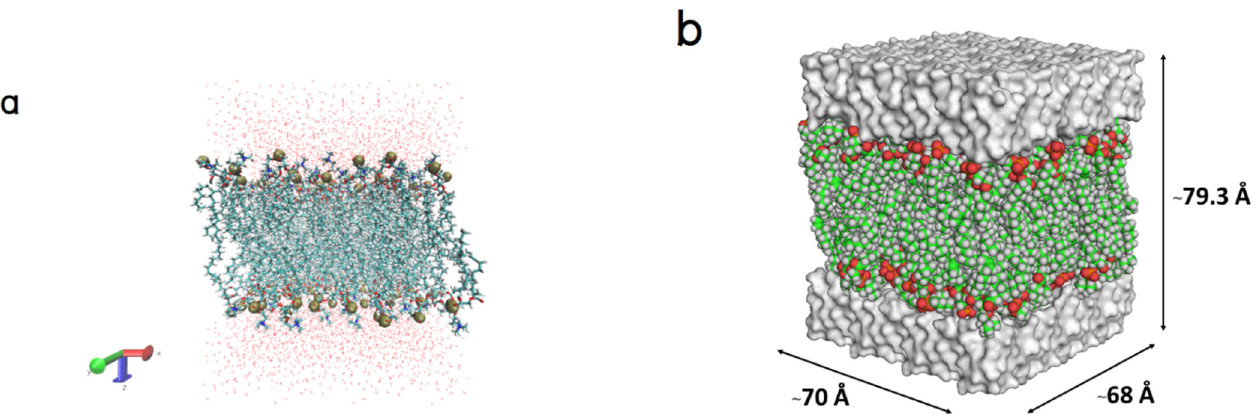
Figure 1. ( a ) The POPC membrane model surrounded above and below by water molecules, POPC and water molecules, and phosphorous atoms are shown in licorice, line, and van der Waals representations, respectively and ( b ) configuration of the POPC membrane. Each color represents a different component of the POPC molecule. The upper and lower white surfaces represent explicit water molecules.